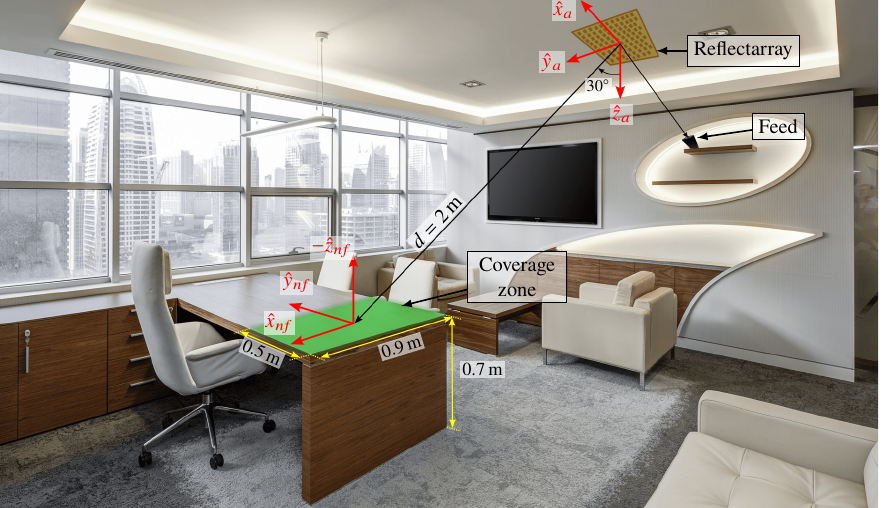
Figure 5. Proposed scenario for indoor femtocell coverage. A reflectarray provides a coverage on top of an office desktop with a maximum desired magnitude ripple of 2dB. Picture adapted from